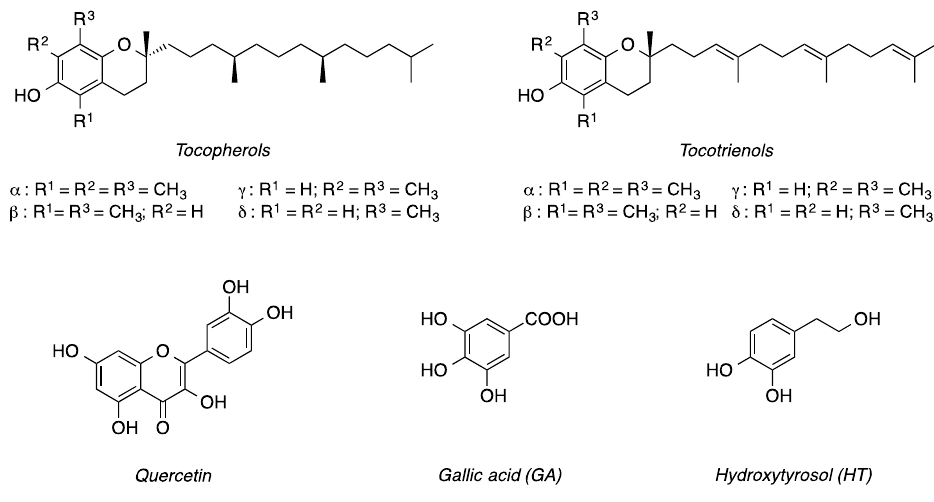
Figure 1. Examples of natural phenolic antioxidants.